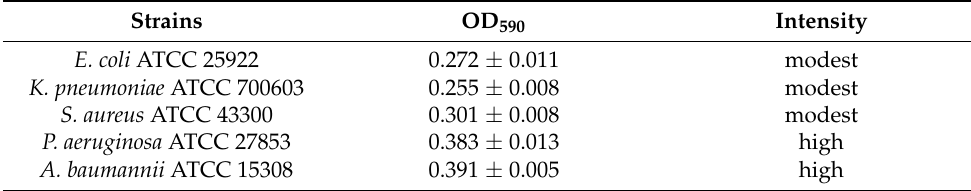
Table 1. Intensity of biofilm formation by reference strains .